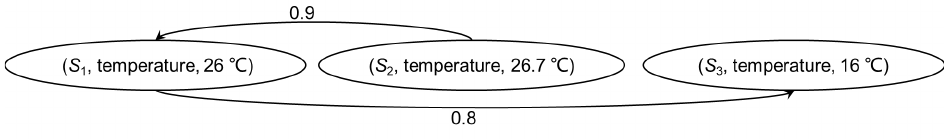
Figure 2. The direct graph of the observations of temperature in Figure